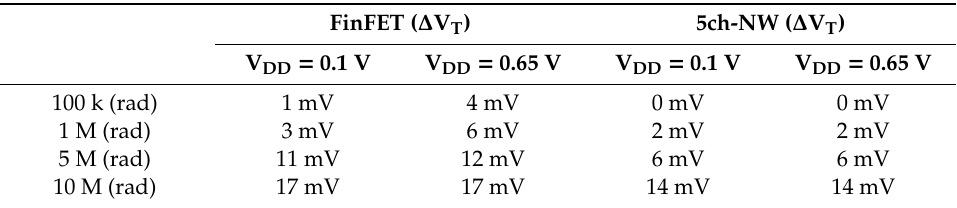
Table 3. V T shift according to the V DD variation.